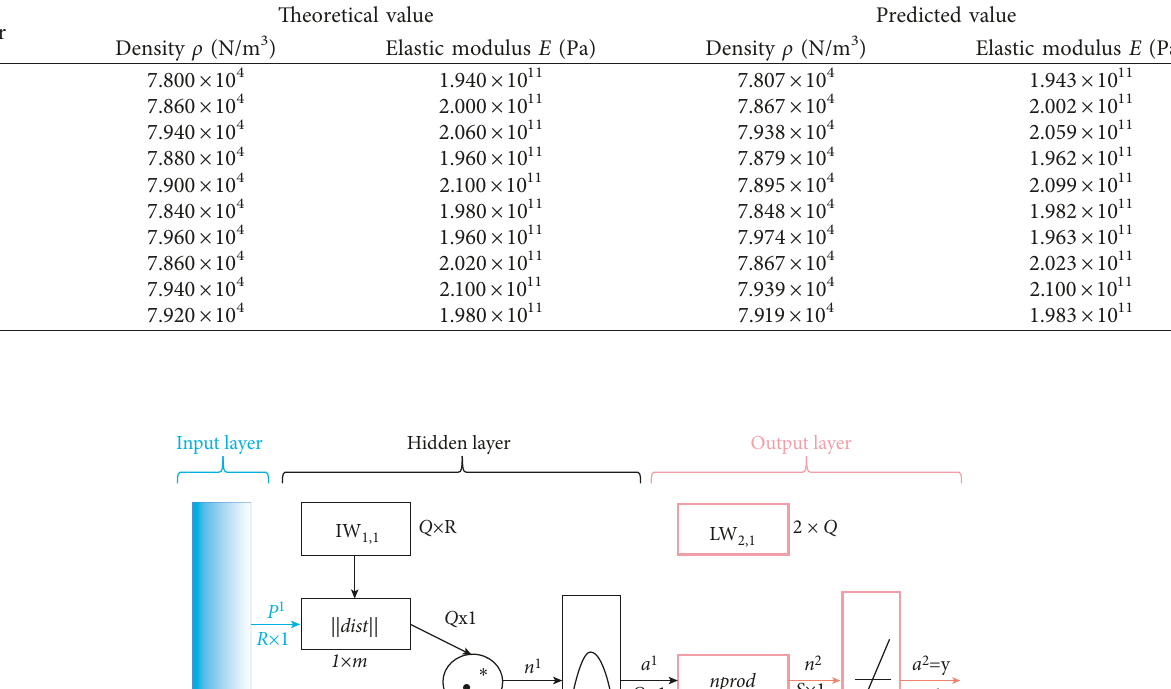
Figure 8: Structure of BP neural network. Table 5: Test results of BP neural network.